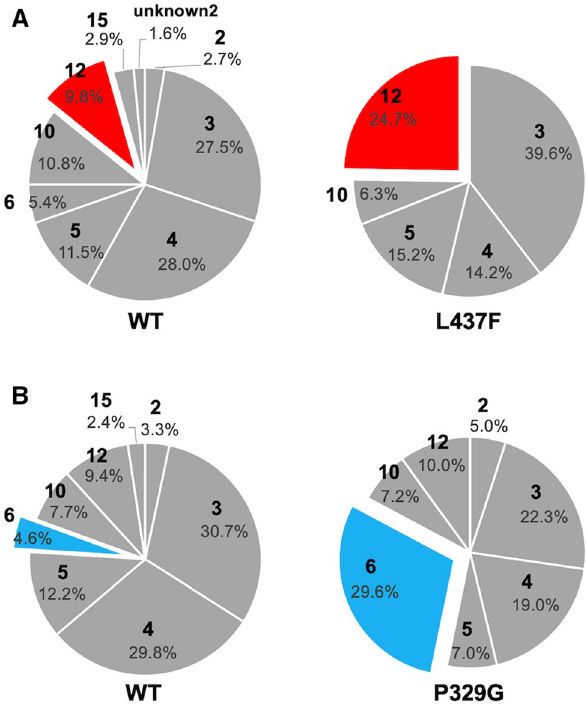
Figure 6. Comparison of reaction product compositions between wild-type CYP102A1 and CYP102A1 mutants. The percentages of oxidized compounds, cis -isopiperitenol ( 6 ) and trans -carveol ( 12 ), were calculated from the peak area of converted total products. These compound ratios of mutants were compared to those of wild type as the positive control for each experiment. ( A ) The data for the L437F mutant are presented as the averages of three independent experiments. The standard deviations for the percentages are included in Supplementary Table 1. ( B ) The data for the P329G mutant are presented as the averages of two independent experiments (Supplementary Table